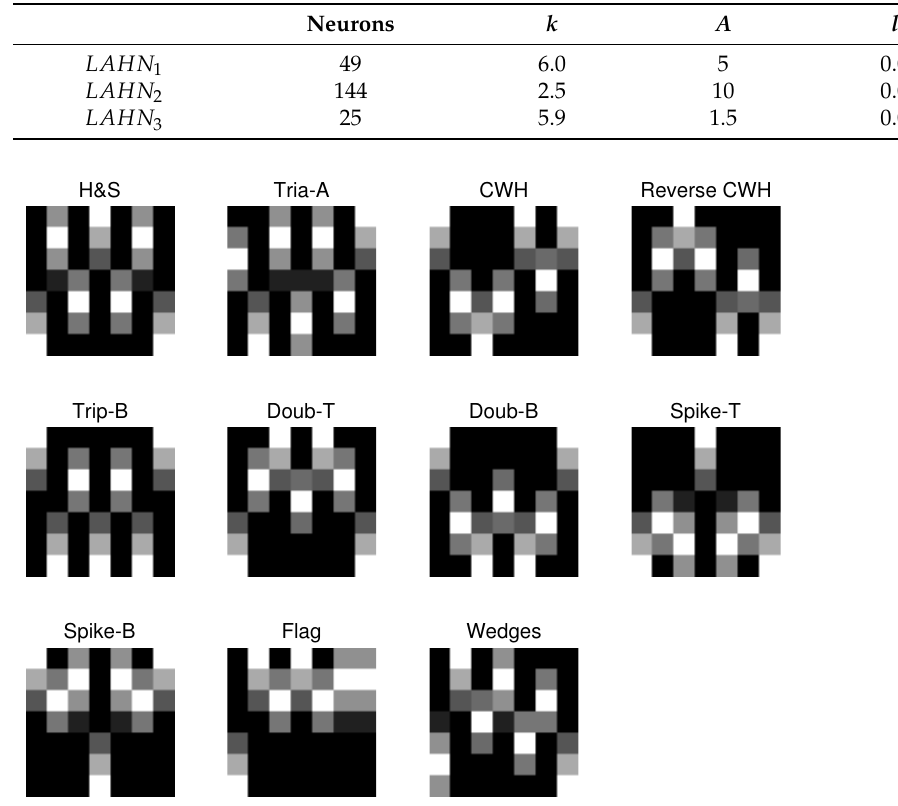
Table A1. Parameters setting of the LAHN. A denotes the diagonal elements of the matrix A , for simplicity, the elements of A are all equal. k denotes the parameter of the activation function. The first column is the number of neurons and the last column is the learning rate.